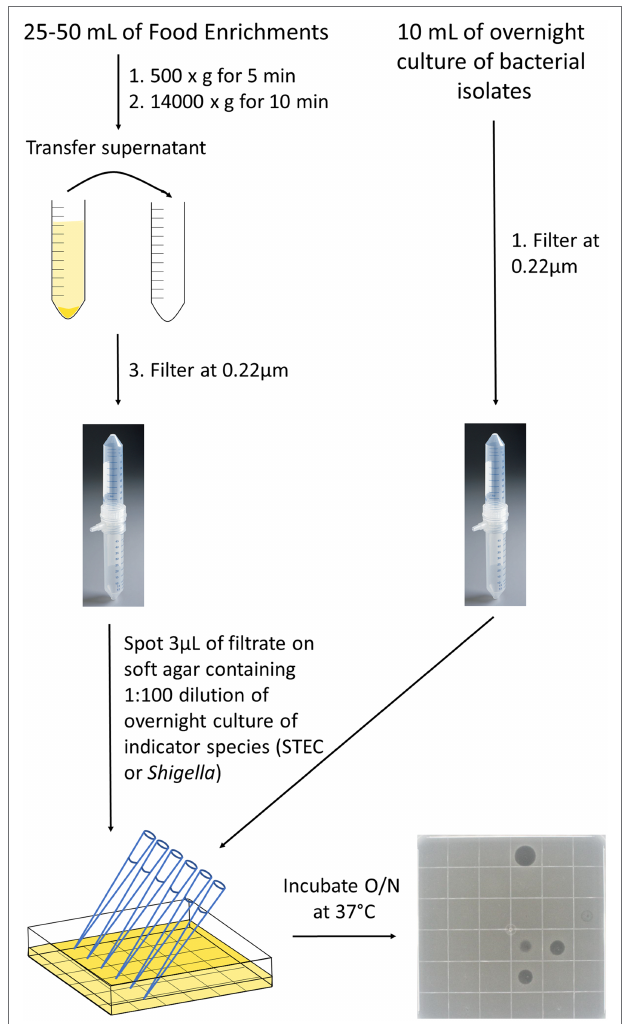
FIGURE 1 | Detection of inhibitors in cell-free extracts from food enrichments or bacterial strains. Bacterial strains were grown overnight in 10 ml of Nutrient broth at 37 ° C (right side) and food enrichments were incubated according to MLFP-26 or MLFP-30 methods. For food enrichments (left side), an aliquot of 25–50 ml was taken and centrifuged first at 500 × g to remove large food particles and then at 14,000 × g to remove bacterial cells and debris. Supernatants from cell enrichments or overnight bacterial cultures were then filtered through a 0.22 μ m vacuum filter to remove remaining food particles and bacterial cells. Filtrates were spotted on soft agar containing indicator strains. Filtrate spots were absorbed into the agar, and plates were incubated overnight at 37 ° C. The following day, pictures were taken to observe the clearings and the diameter of the clearings were measured in millimeters. A representative plate with 35 different cell-free extracts and a negative control spotted in a 6 × 6 grid is